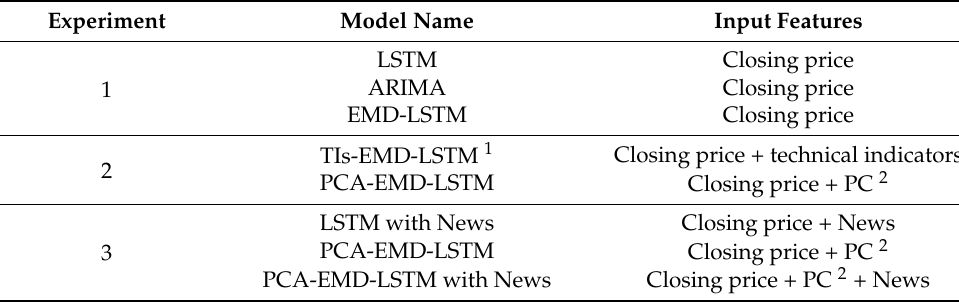
Table 4. Details of the model and input features in each experiment.